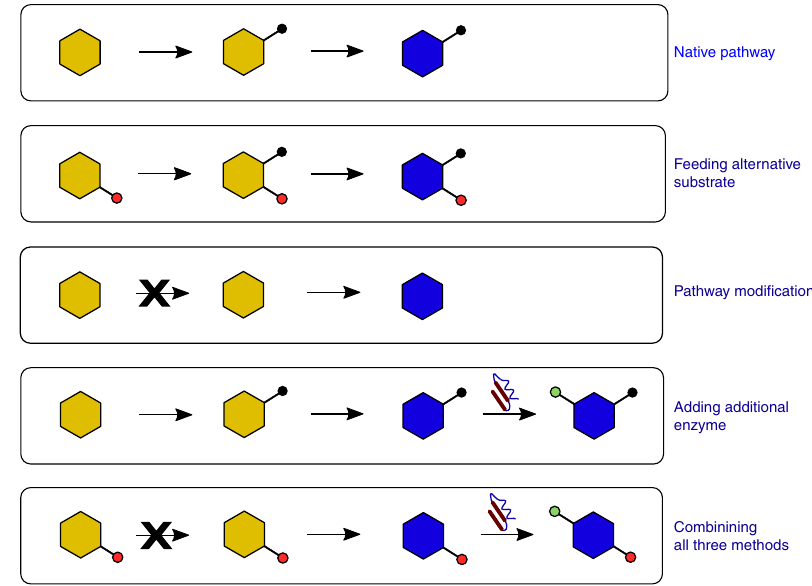
Fig. 4 Potential means of producing novel metabolites once a heterologous pathway to a natural PNP is produced in a microbial host. An example heterologous PNP biosynthetic pathway (top row) can be leveraged to produce novel products in a number of ways: (1) feeding unnatural substrates which are then functionalized by downstream enzymes (second row), (2) removing pathway enzymes to exclude biosynthetic steps (third row), or (3) adding additional enzymes to functionalize intermediates or the fi nal product (fourth row). These three strategies can then be combined in order to afford a wealth of additional products ( fi fth